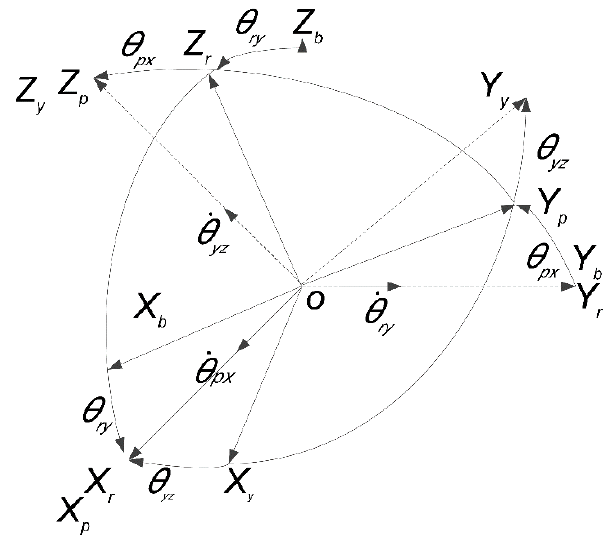
Figure 3. Rotation of the azimuth axis by θ yz around the pitch axis.